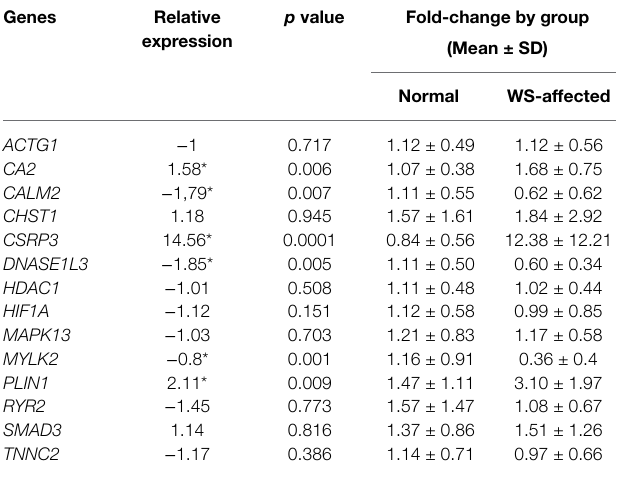
TABLE 2 | Relative expression (fold-change) between normal and WS-affected broilers, respective p values, and expression levels calculated for each group.